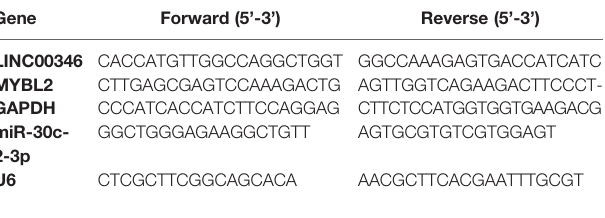
TABLE 1 | Primer sequence for